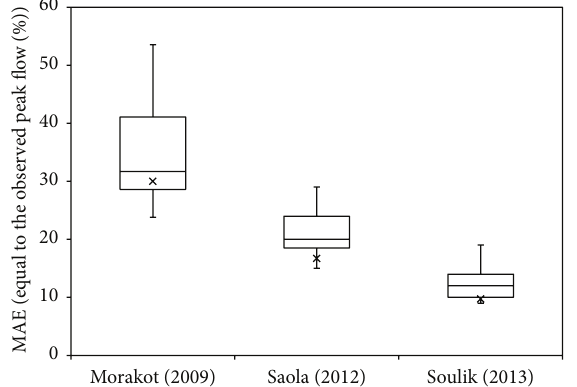
Figure 10: The error of total inflow forecast for three applications in function of cumulative length of time. The maximum of the error of total inflow varied from almost zero to 179 percent and can be reduced significantly when the cumulative length of time is larger than